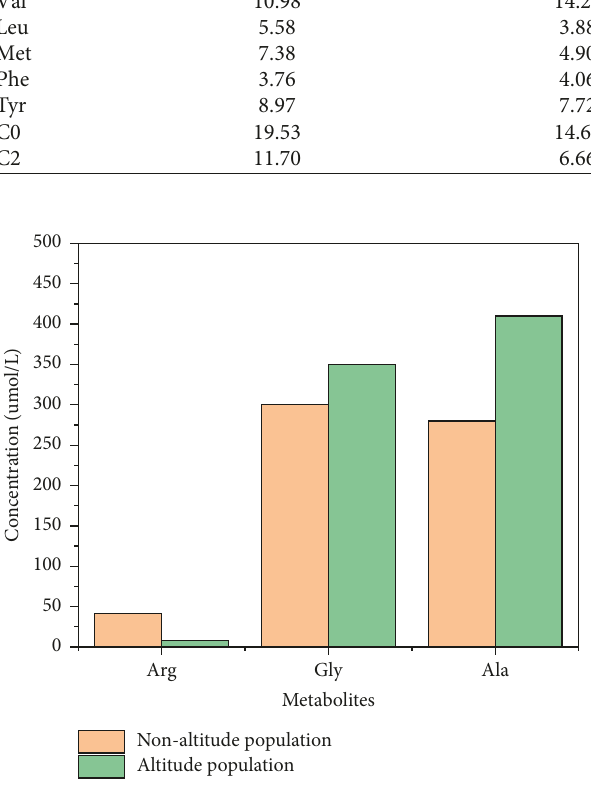
Figure 4: Reference amount of human peptide drug quality de- livery in different